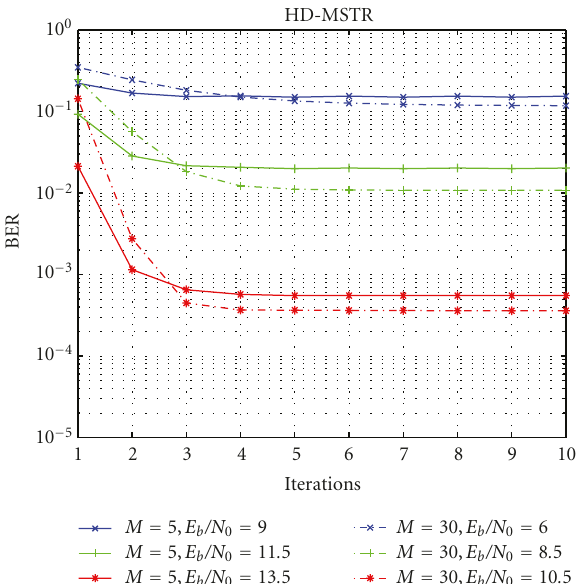
Figure 5: Convergence rate of HD-MSTR with M = 5, 30 in di ff erent SNR level.